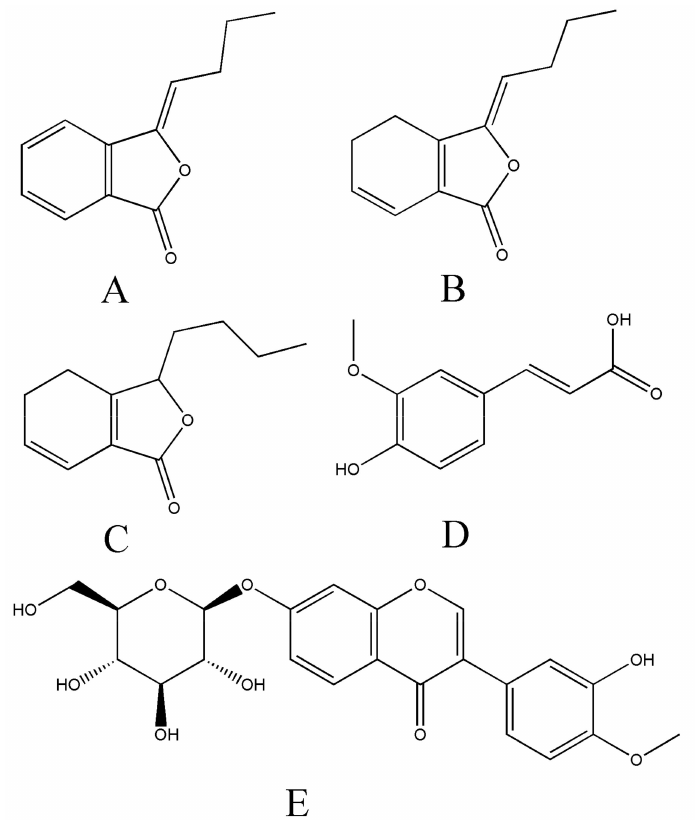
Figure 1. Chemical structures of butylidenephthalide ( A ), ligustilide ( B ), senkyunolide A ( C ), ferulic acid ( D ) and calycosin-7- O - β - d -glucoside ( E ,